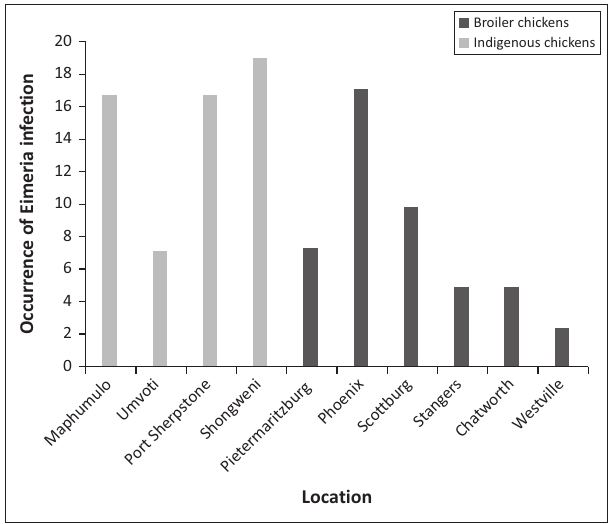
FIGURE 2: Occurrence of Eimeria infection in different locations in KwaZulu-Natal.